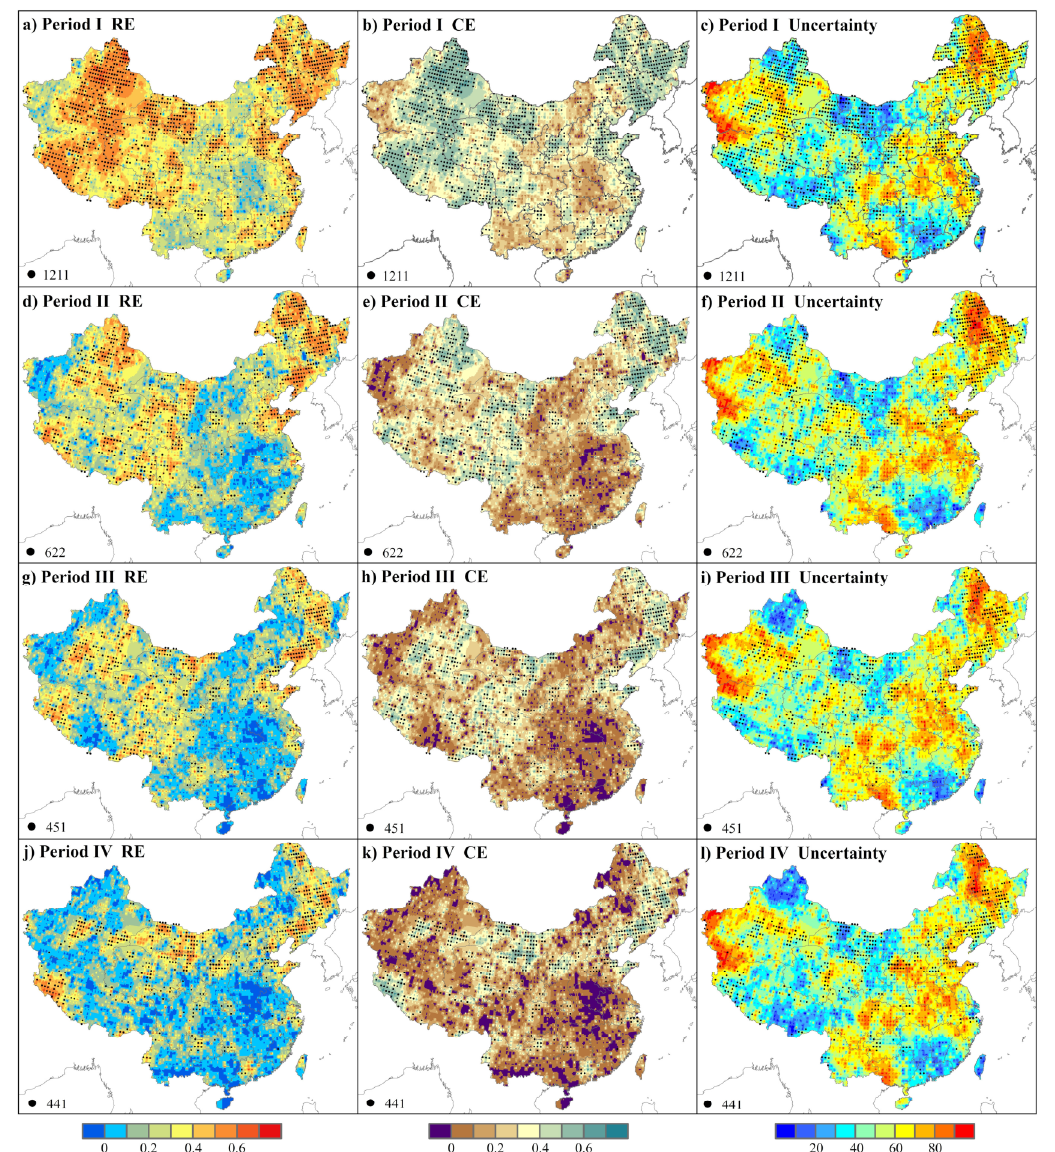
Figure 5. Skills of the reconstructed scPDSI in China for the calibration/verification period. The black dots represent grid points with qualified training accuracy ( n = 37, r > 0.2709, p -value < 0.1) and qualified testing accuracy ( n = 13, r > 0.4575, p -value < 0.1). The RE and CE are the reduction of error